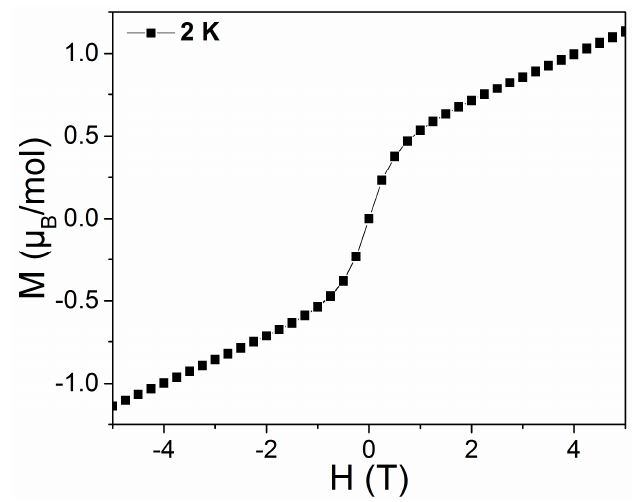
Figure 6. Variation of magnetization versus magnetic field at 2 K.